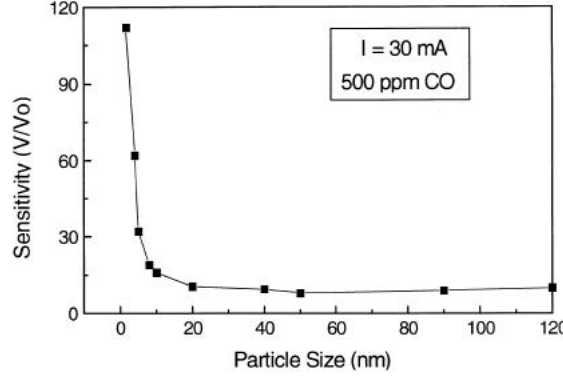
Figure 7. Effect of particle size on gas sensitivity for CO (adapted from [50]).